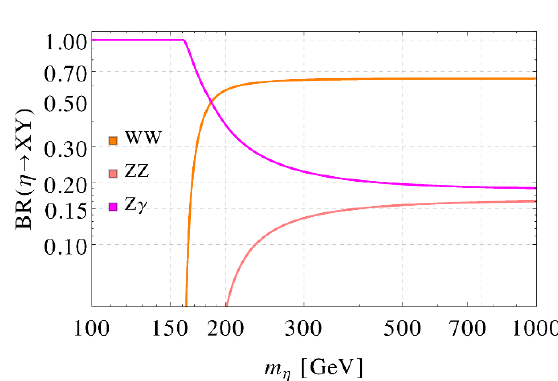
Figure 3 . Branching ratio of (cid:17) as a function of m (cid:17) in the benchmark SU(4) = Sp(4) models intro- duced in section